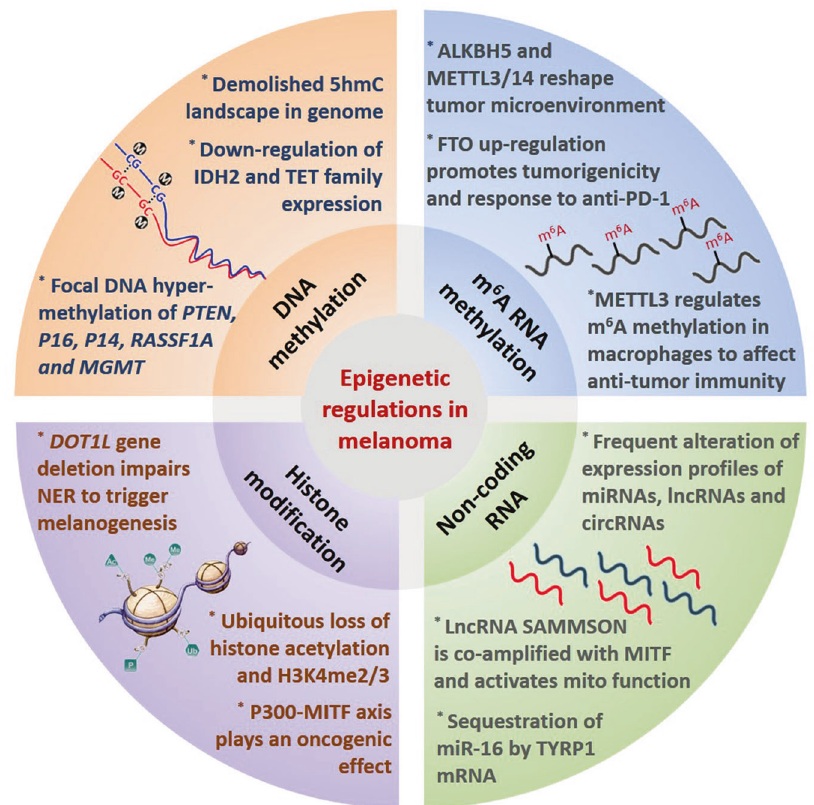
Fig. 5 Epigenetic regulation in melanoma. Main paradigms of epigenetic modi fi cation and representative effects on cancer biology in